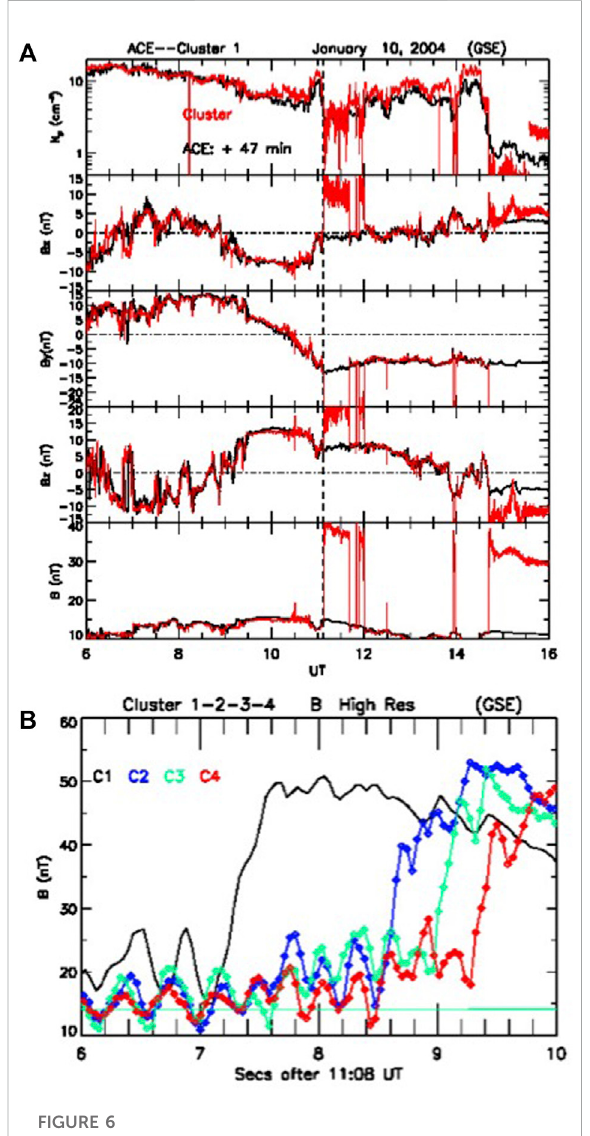
FIGURE 6 (A) (top).OverlayofACE(black)andCluster1(red)dataforthe interval 6 to 16 UT. ACE data have been delayed by 47 min. (B) (bottom): The crossing of the bow shock by the four Cluster spacecraft.